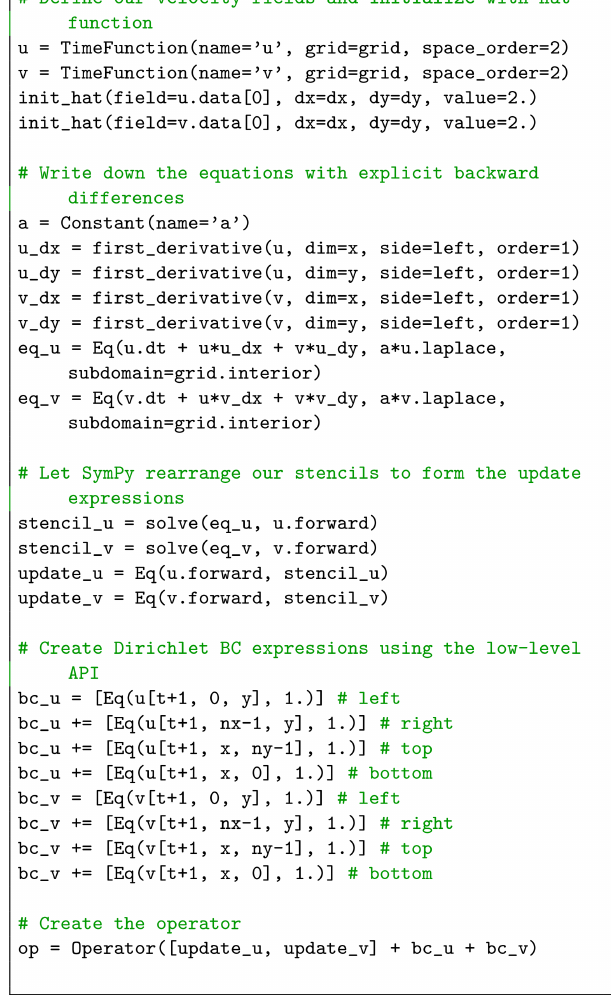
Figure 16. Burgers’ equations in Devito. In this example, we ex- plicitly use the FD function first_derivative . This function provides more flexibility and allows us to take an upwind derivative, rather than a standard centered derivative ( x ), to avoid odd–even coupling, which leads to chessboard artifacts in the